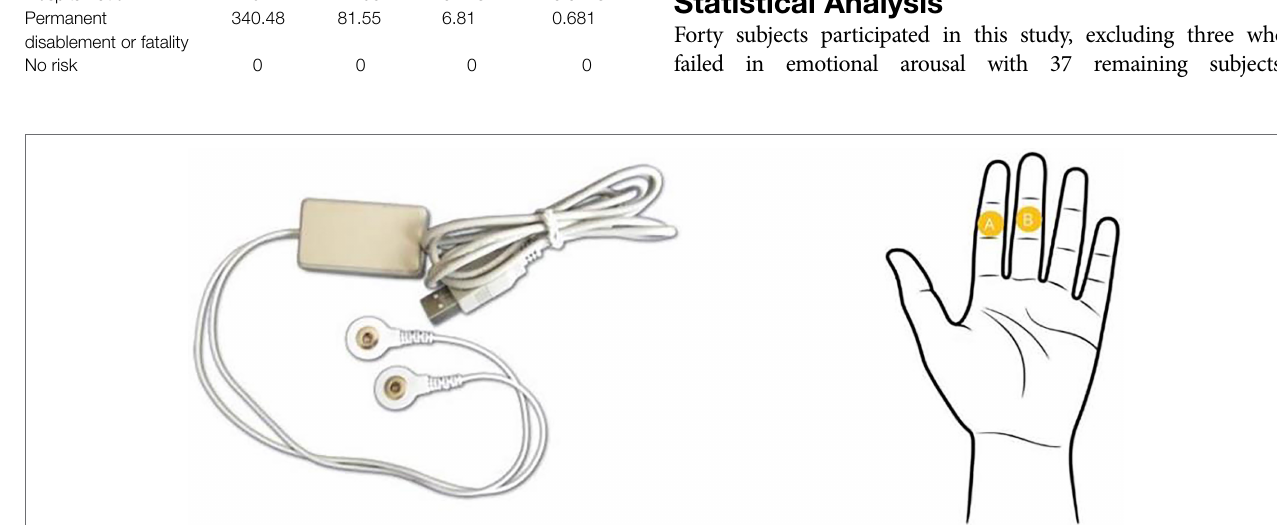
FIGURE 2 | GSR equipment and attachment